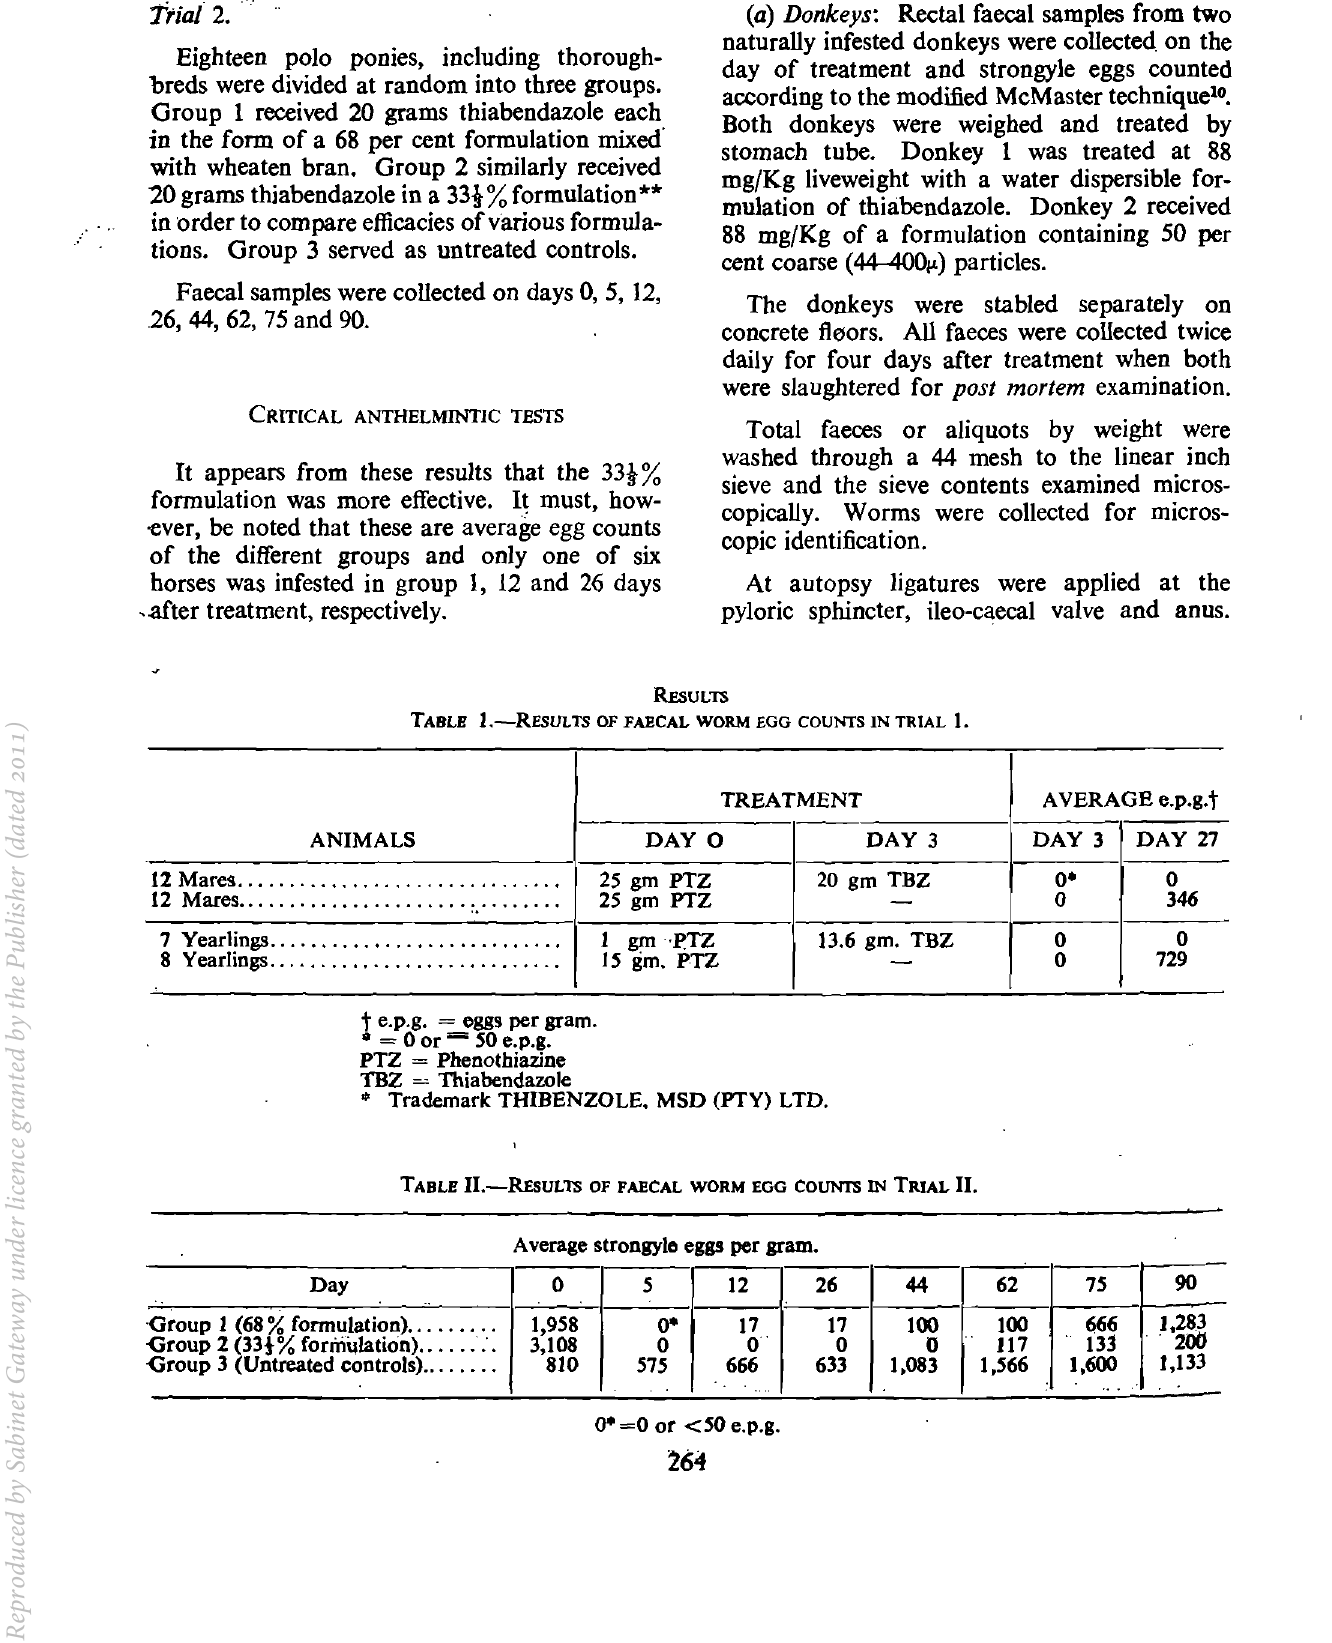
TABLE n.-RESULTS OF FAECAL WORM EGG COUNTS IN TRIAL II. Average strongyle eggs per